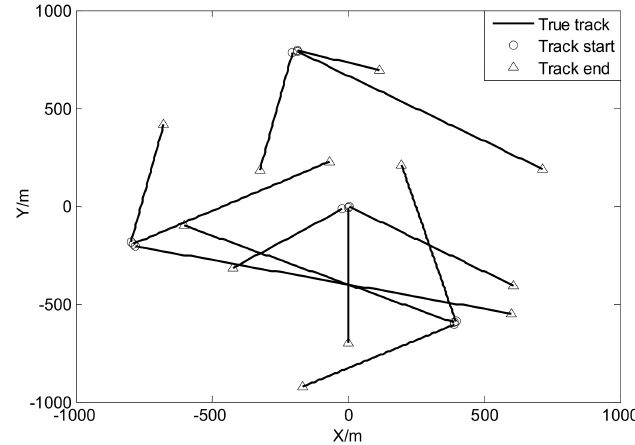
Figure 2. True trajectories of each